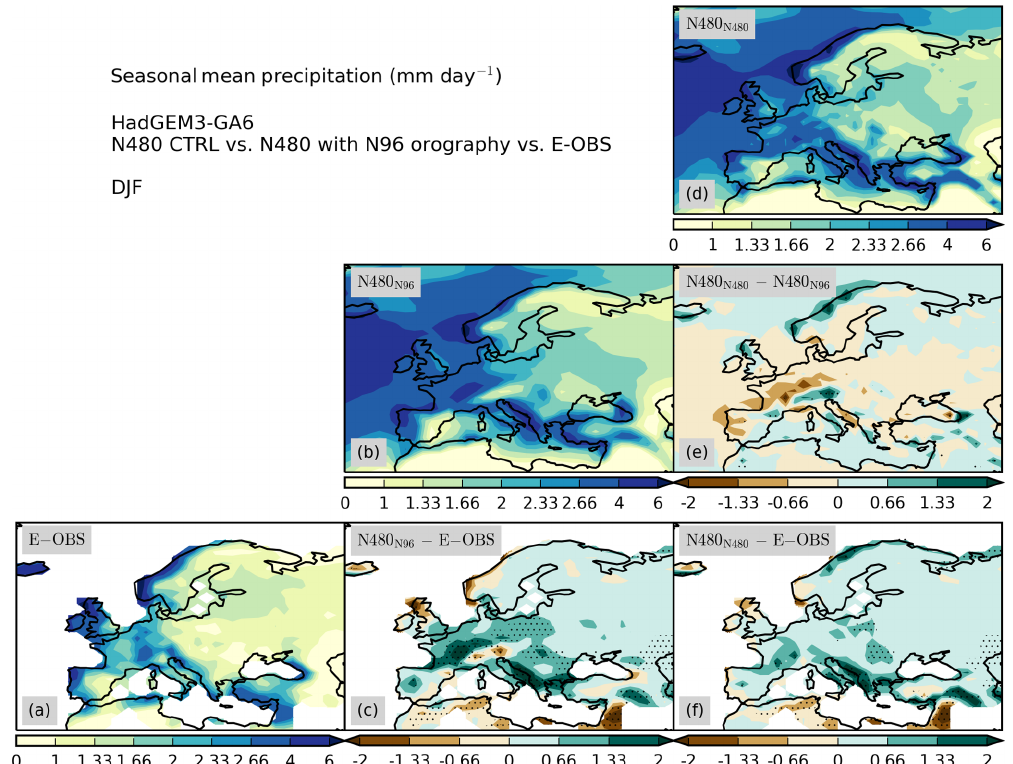
Figure 9. Winter (December–February) precipitation in mmday − 1 in (a) observations (E-OBS), (b) the N480 model with N96 orography, and (d) the N480 control simulation. (c, f) Model bias with respect to E-OBS and (e) difference between the two model simulations. Stippling shows statistically significant differences.